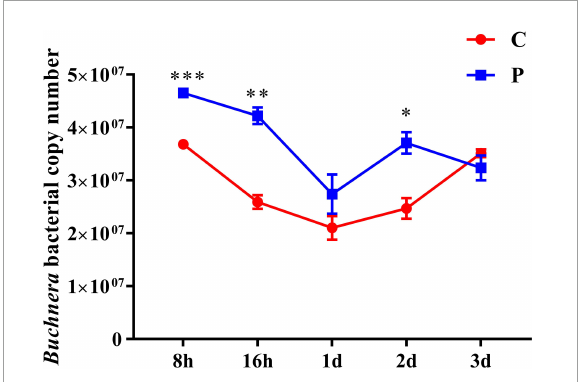
FIGURE7 Changes in abundance of symbiotic bacteria Buchnera in cotton aphid. C, Non-parasitized cotton aphids; P, Parasitized cotton aphids. Statistical significance (Student’s t -test): * P < 0.05; ** P < 0.01; *** P <